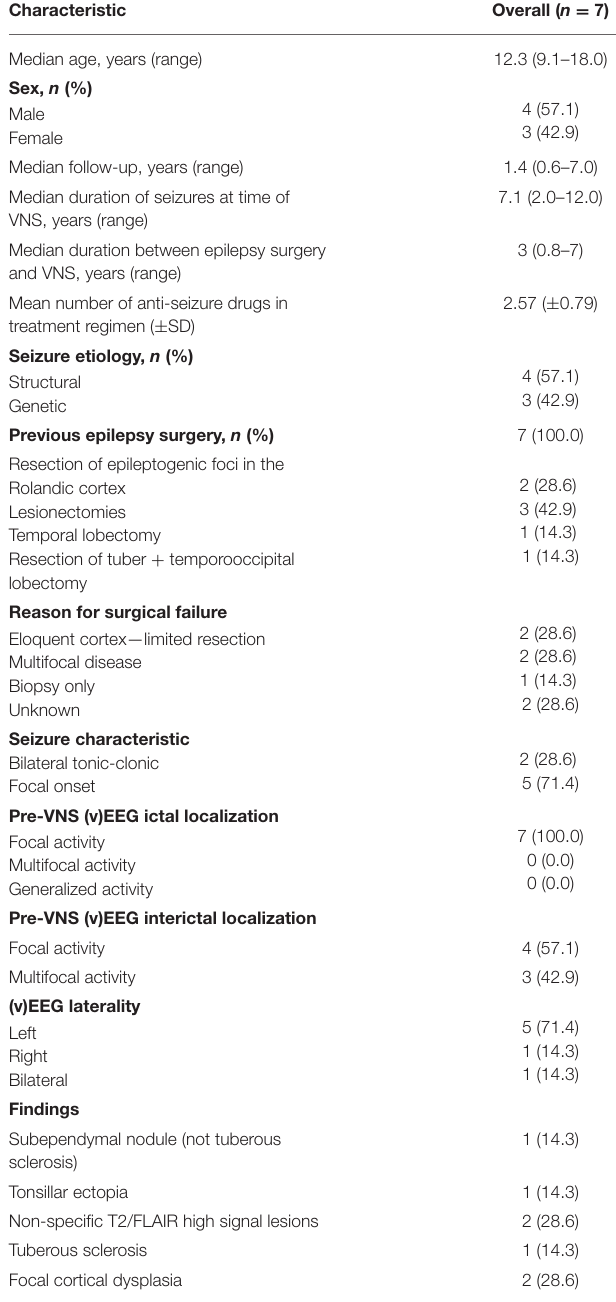
TABLE 1 | Demographic information of included